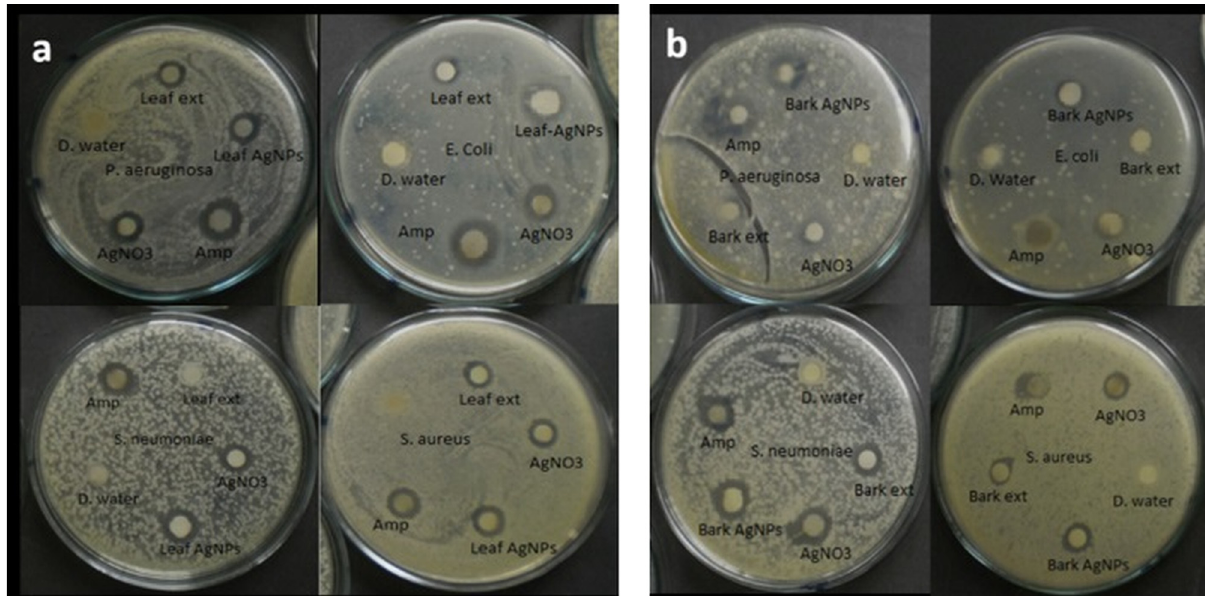
Figure 9: Visual evidence of formation of zones of inhibition by biosynthesized leaf - mediated Ag - NPs ( a ) and bark - mediated Ag - NPs ( b ) .